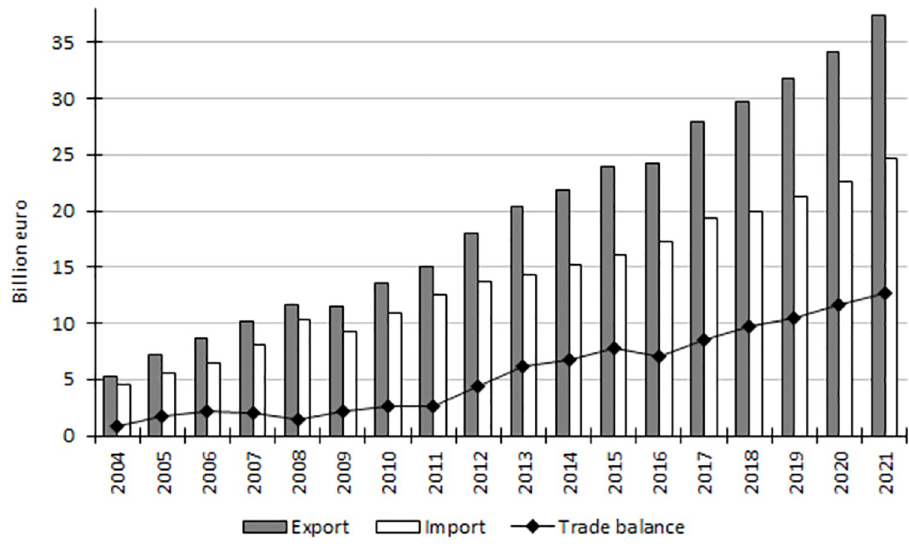
Fig 2. Poland’s foreign trade in agri-food products in 2004–2021 (billion euro). Source: [13], the authors’ elaboration.